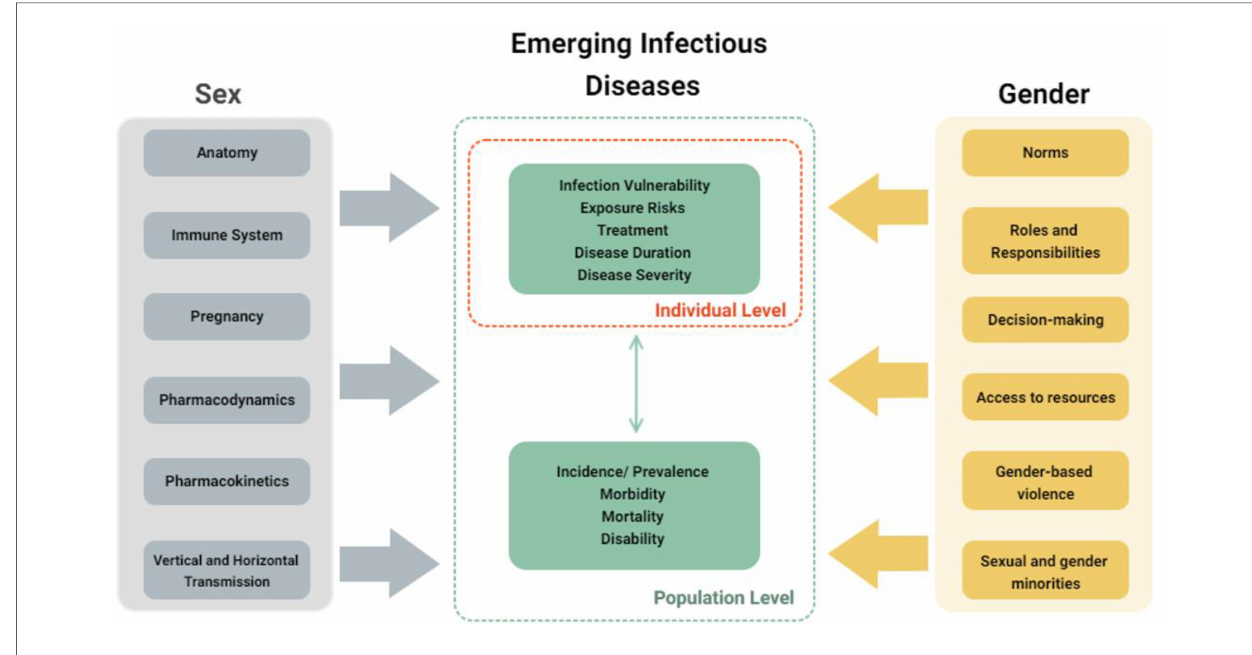
FIGURE 1 Conceptual framework for sex and gender effects in emerging infectious